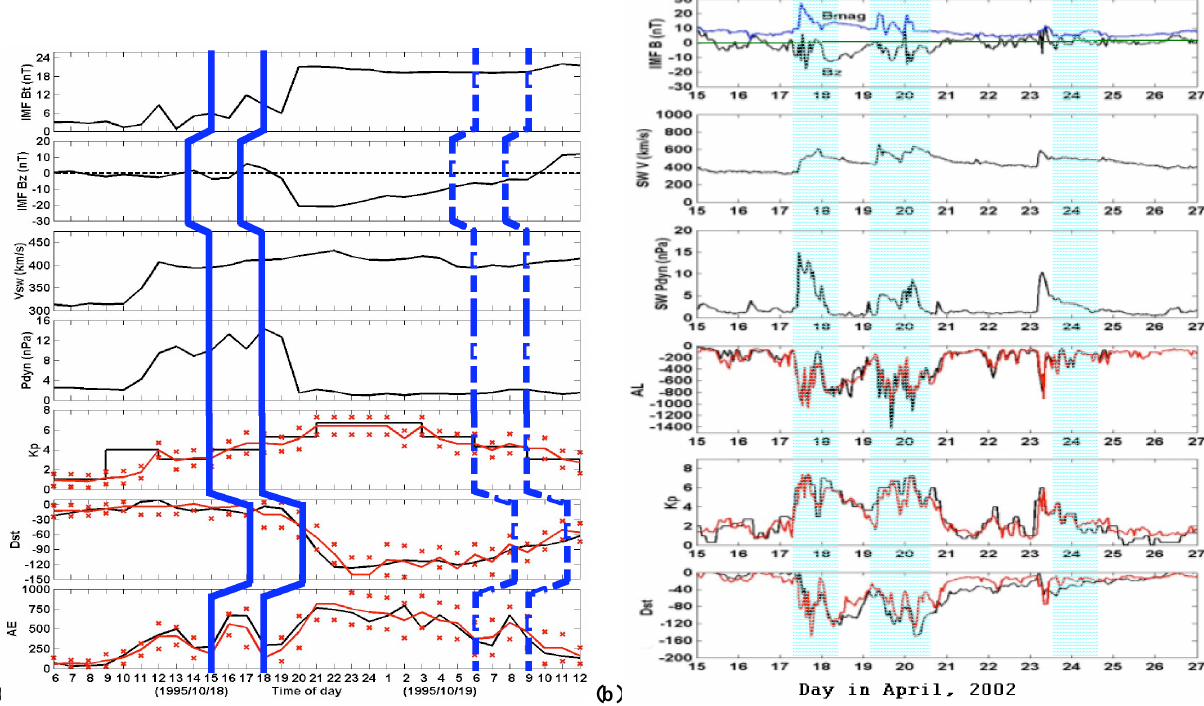
Figure 7(b) Fig. 7. (a) Evolution of magnetospheric states, 9(t) , over a magnetic cloud interval on 18–19 October 1995 (Fenrich and Luhmann, 1998) is manifested by the continuously changing magnetospheric state parameters. With a fixed set of time shifts, as marked by the blue (solid and broken) lines, the temporal progressions of the time-series records of the different magnetospheric state parameters simply mark the temporal changes in the magnetospheric states. The red curves show average prescribed geomagnetic responses in remarkable agreement with observations (black curves). The red crosses give a one standard deviation error estimate. (b) Illustration of successful simultaneous specification of AL , K p , and D st by magnetospheric state prescriptions (with mean square-root error of 131.2, 0.94, and 21.3, respectively) over an interval of multiple storms with varying magnitudes observed on 15–27 April 2002. The prescribed geomagnetic indices (red curves) and their observed values (black curves) have correlation coefficients of 0.89, 0.90, and 0.83,